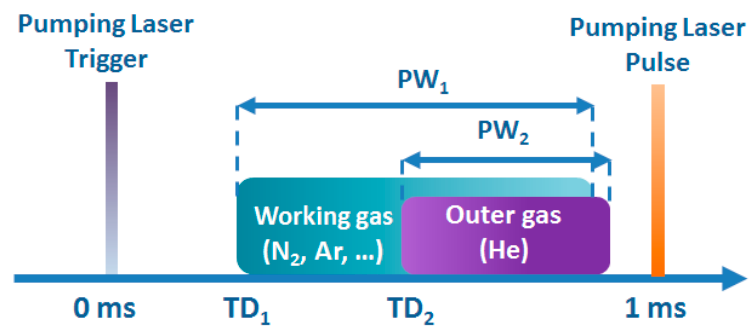
Figure 2. Scheme of the delay timing setting for the laser-plasma source based on a double stream gas-puff target. Figure modified, based on [70].